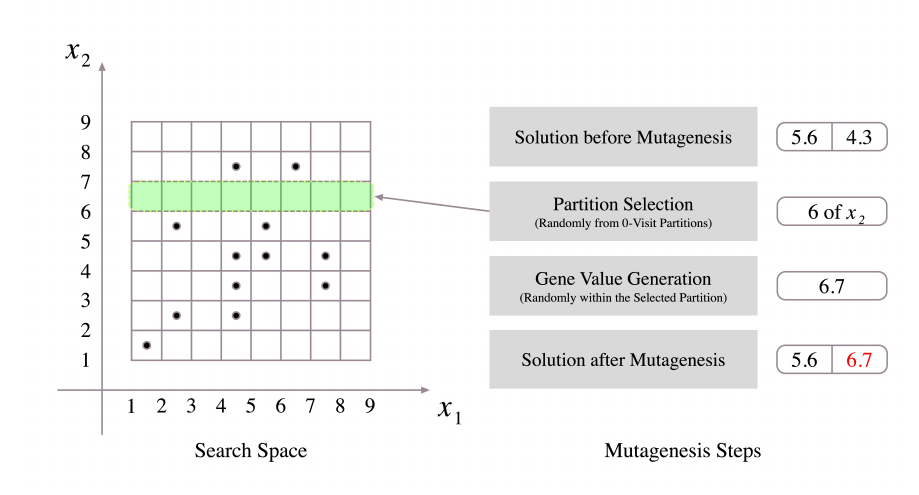
Figure 6. An Example of the mutagenesis steps in two